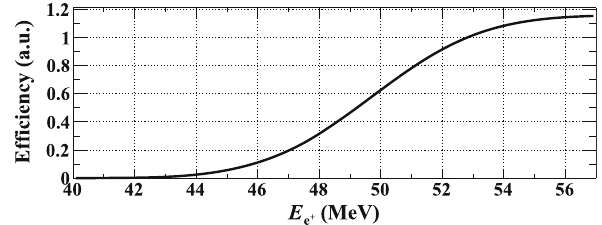
Fig. 5 COBRA spectrometer relative efficiency as a function of E e + normalised to (cid:6) e + ( 52 . 83 MeV) = 1 a C-shaped structure fitting the outer radius of the